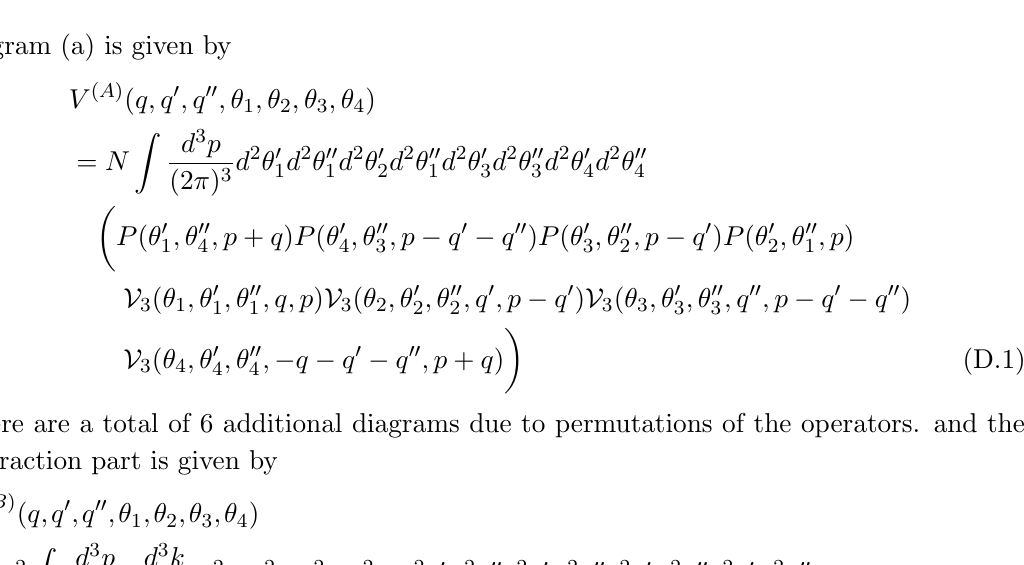
Figure 9 . The contributing diagrams for the four point function of currents. The (cid:12)rst diagram is diagram type (a). The grey blob in (b), (c), (d) represents the all loop four point correlator. The remaining diagrams are obtained by permutations of the external